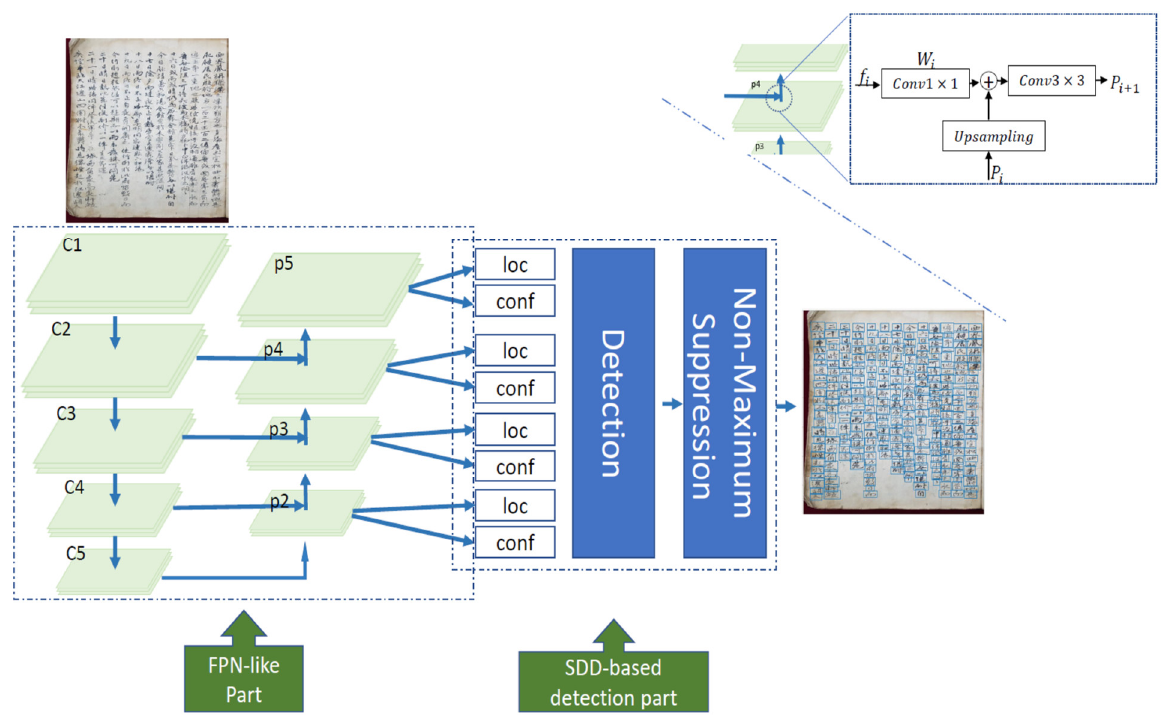
Figure 3. The architecture of the proposed FAN-MCCD: the FPN-like part, which is a multi-scale feature using fully convolutional network (FCN) with channels of halved-value for the purpose of obtaining characters at different sizes; the SSD-based part, which depends on pre-selected boxes using focal loss for more accurate classification during detection and to suppress the background noise problem in old documents; and the NMS for pruning these bounding boxes. The upper right corner explains the merging process using element wise addition.